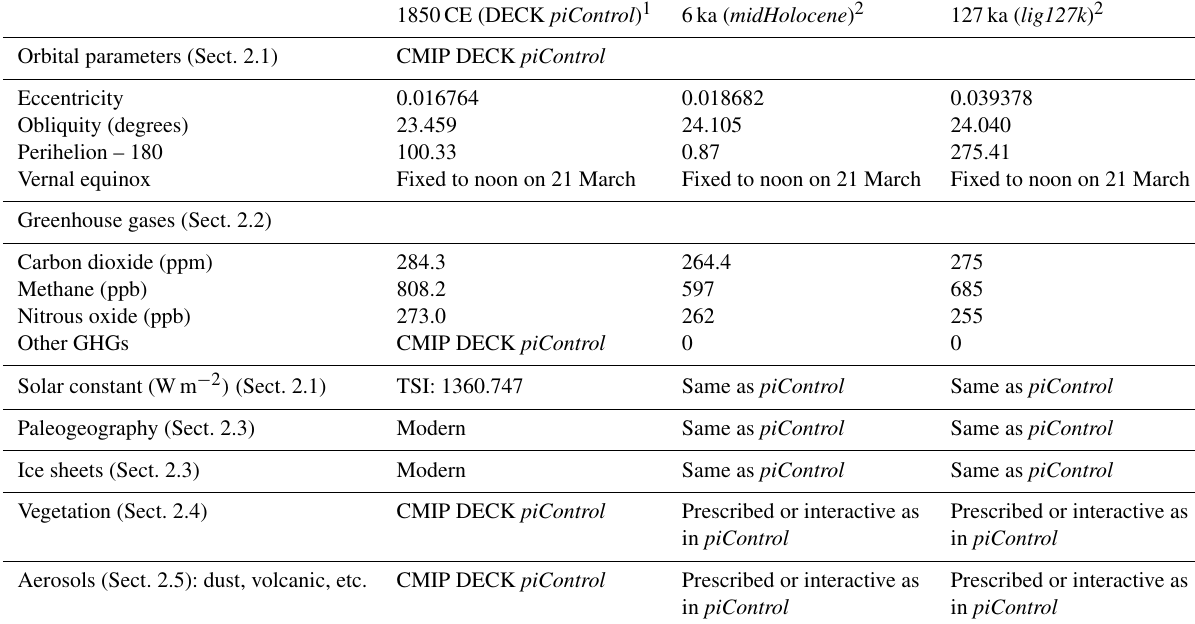
Table 1. Forcings and boundary conditions. More details can be found in the section numbers indicated in parentheses.